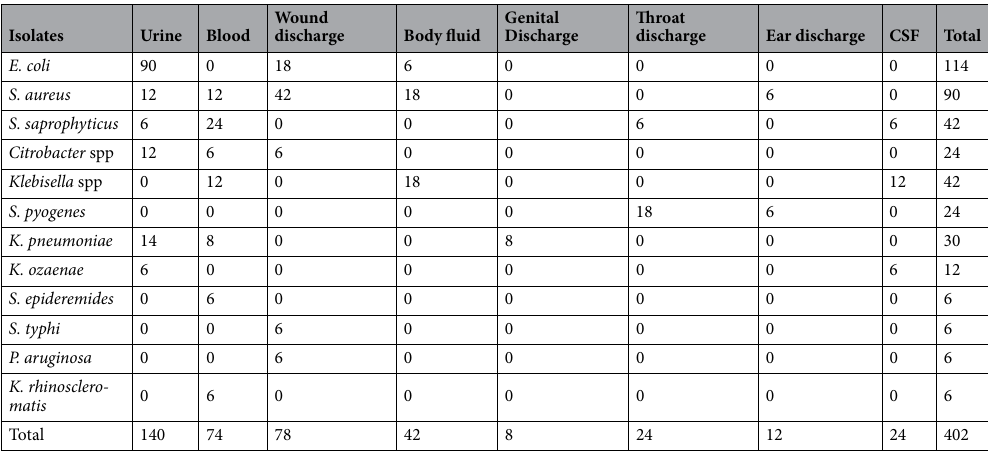
Table 2. Cross tabulation of the clinical samples analyzed with the type of bacteria